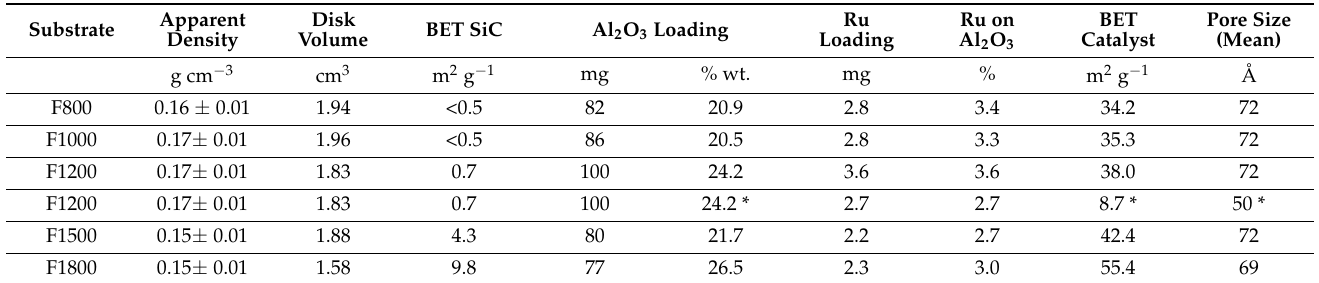
Table 1. Geometric, compositional, and textural features of SiC foams and their corresponding RuA-Fxxxx catalysts after reduction.